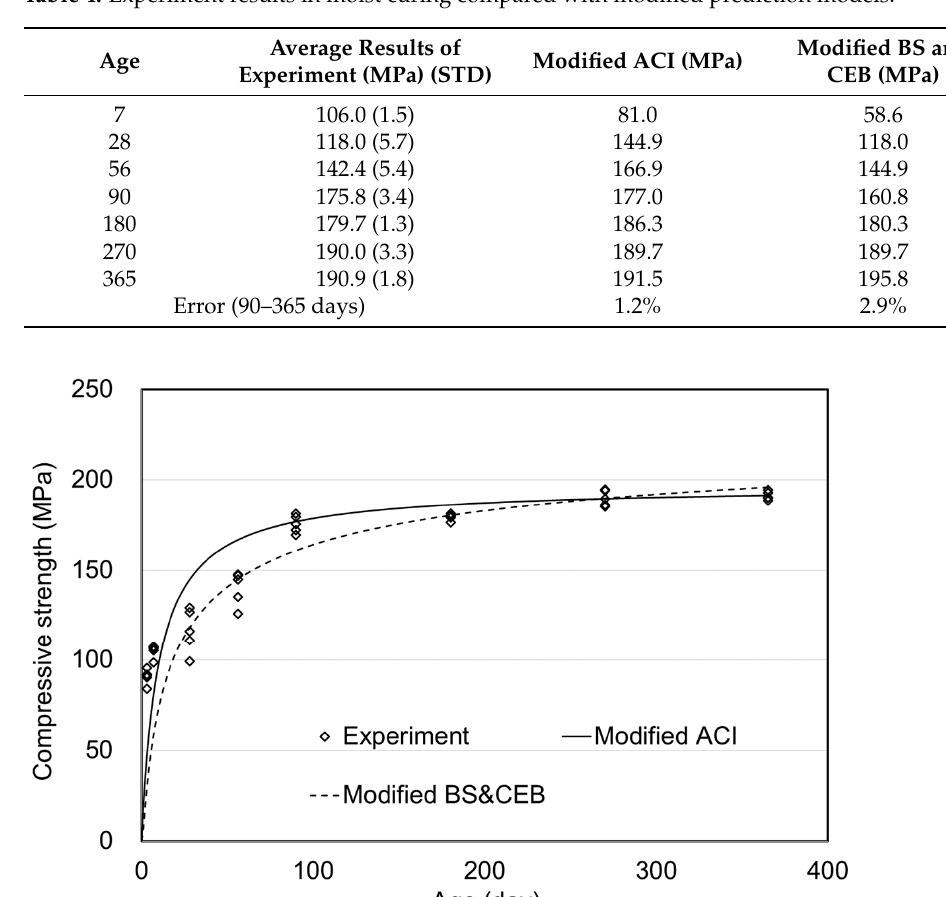
Figure 8. Prediction model of compressive strength for moist curing.